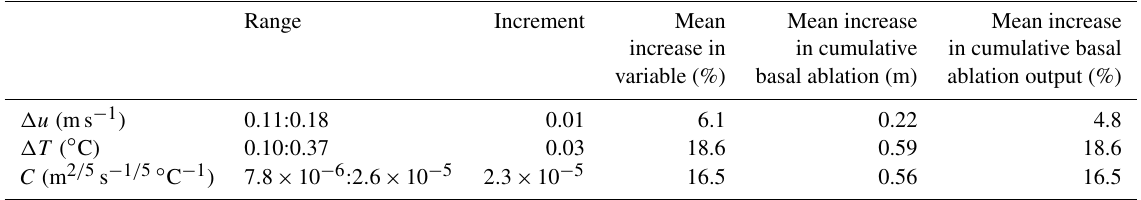
Table 3. Descriptive statistics and sensitivity analysis results. The key driving variables in the forced convection basal ablation model were individually perturbed in eight equal increments based on the variable’s range. The sensitivity of the model was assessed as the mean percent increase in predicted cumulative basal ablation following each incremental increase in the value assigned to a given variable. The sensitivity was analyzed over the longer time period (15 November 2015 to 18 September 2016) due to the certainty in the bulk basal ablation. Range Increment Mean Mean increase Mean increase increase in in cumulative in cumulative